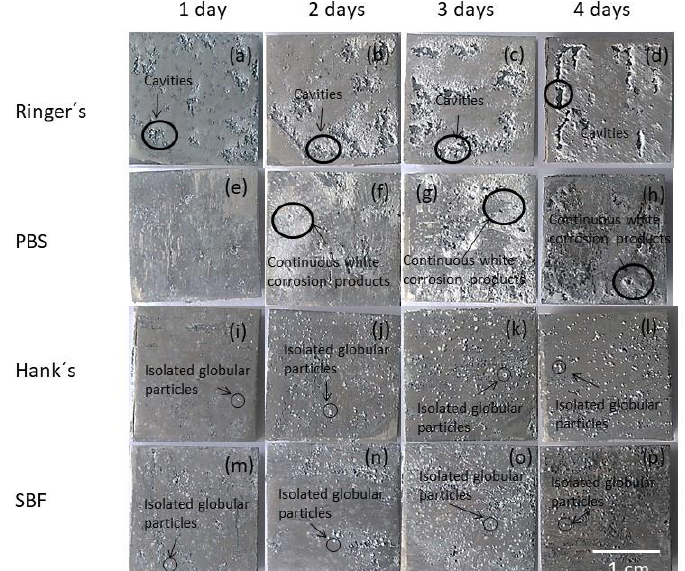
Figure 1. ( a – d ) Surface appearance of the AZ31B specimens as a function of immersion time in Ringer’s; ( e – h ) phosphate-buffered saline (PBS); ( i – l ) Hank’s, and ( m – p ) simulated body fluid (SBF) solutions.